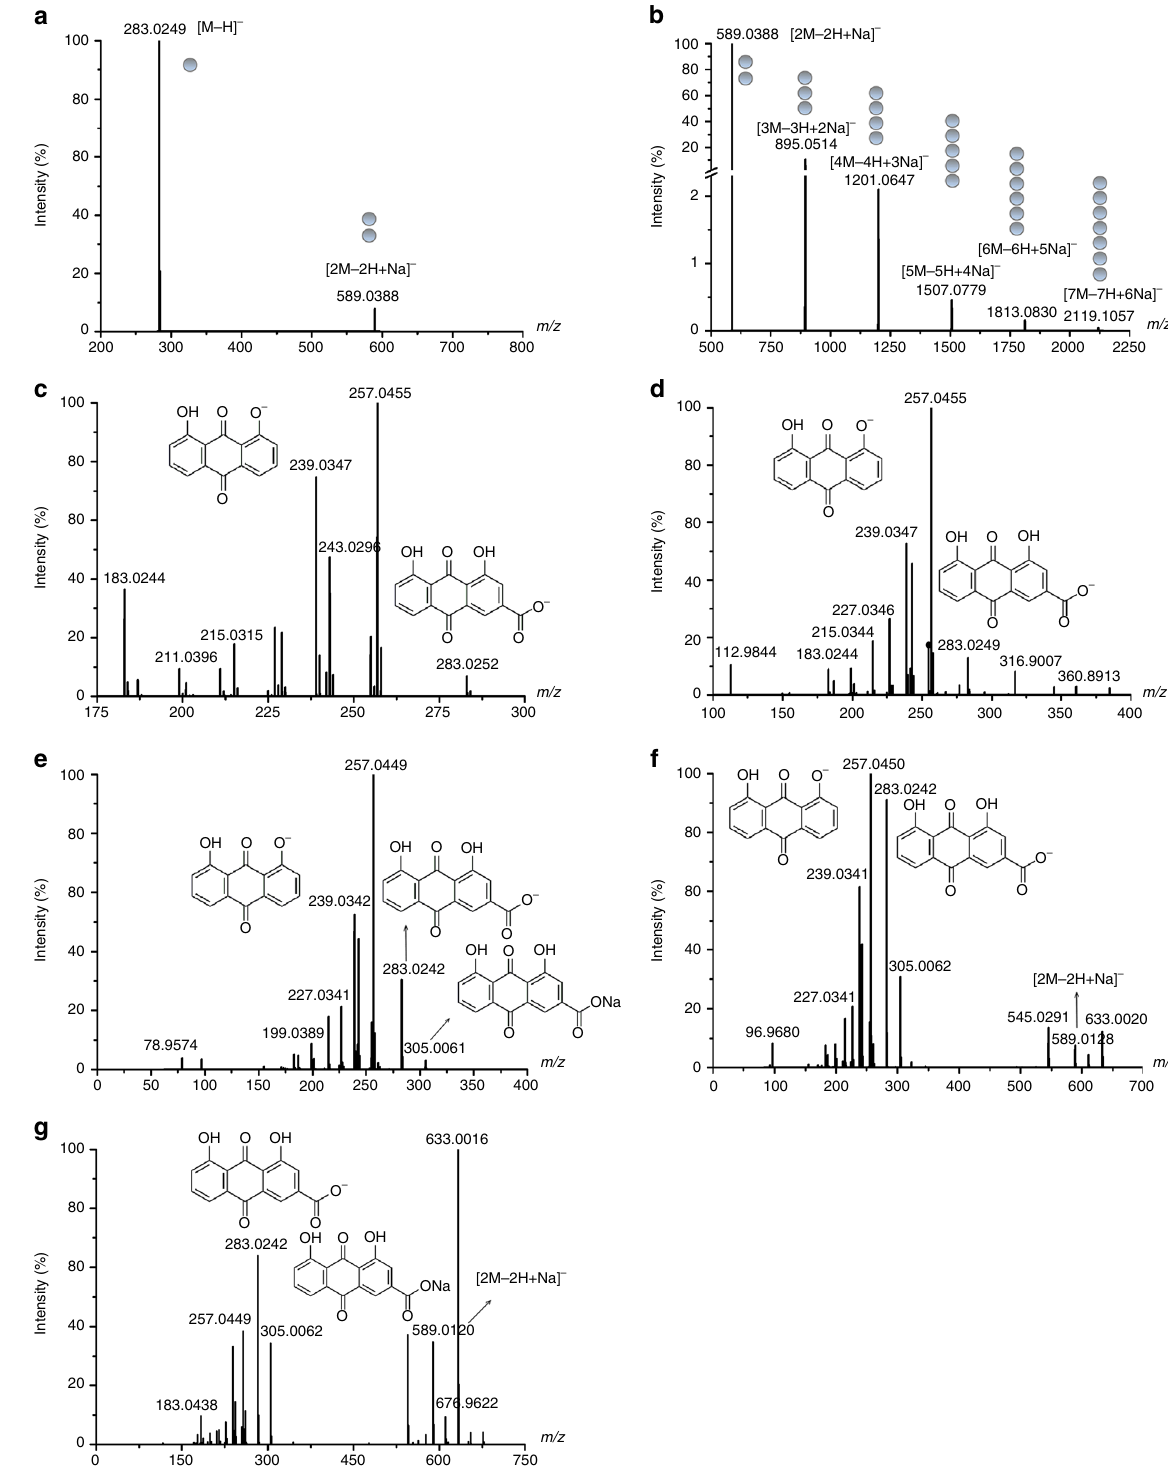
Fig. 2 Mass spectrometric analysis of the rhein hydrogel. a , b MS analyses of the rhein hydrogel. c MS/MS analyses of monomer [M − H] − . d MS/MS analyses of dimer [2M − 2H + Na] − . e MS/MS analyses of trimer [3M − 3H + 2Na] − . f MS/MS analyses of tetramer [4M − 4H + 3Na] − . g MS/MS analyses of pentamer [5M − 5H + 4Na] −